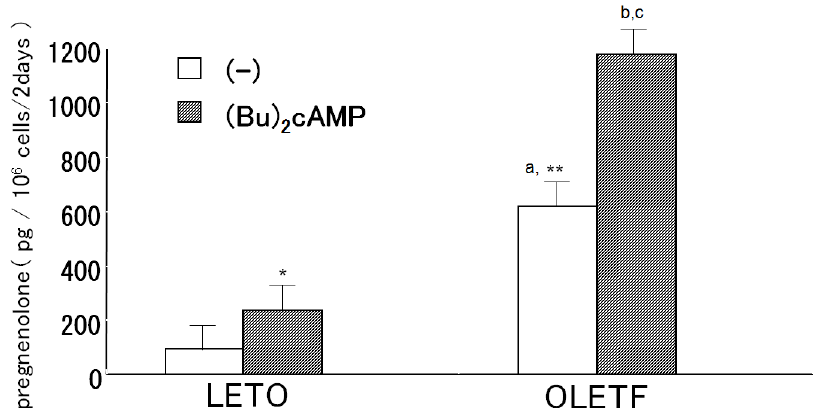
Figure 2. Pregnenolone production by rat AoSMC. The cells were cultured with/without (Bu)2cAMP for 2 h and then incubated with 30 μ M trilostane, which is an antagonist of 3 β HSD. Pregnenolone concentrations were assessed using a specific radioimmunoassay. Results are expressed as the mean ± S.E.M. * p < 0.05 vs. control (no additives); ** p < 0.001 vs. control of LETO (no additives). a p < 0.01 vs. +(Bu)2cAMP of LETO, b p < 0.01 vs. control of OLETF (no additives), c p < 0.001 vs. +(Bu)2cAMP of